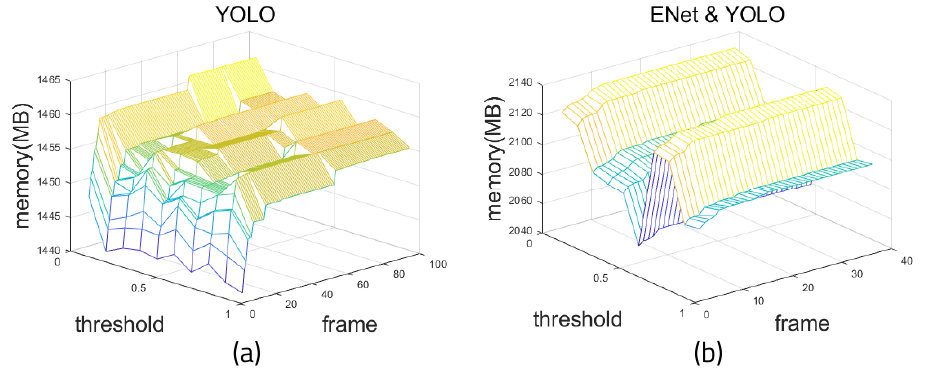
Figure 16. Relationship between memory usage and threshold: ( a ) YOLO and ( b ) ENet and